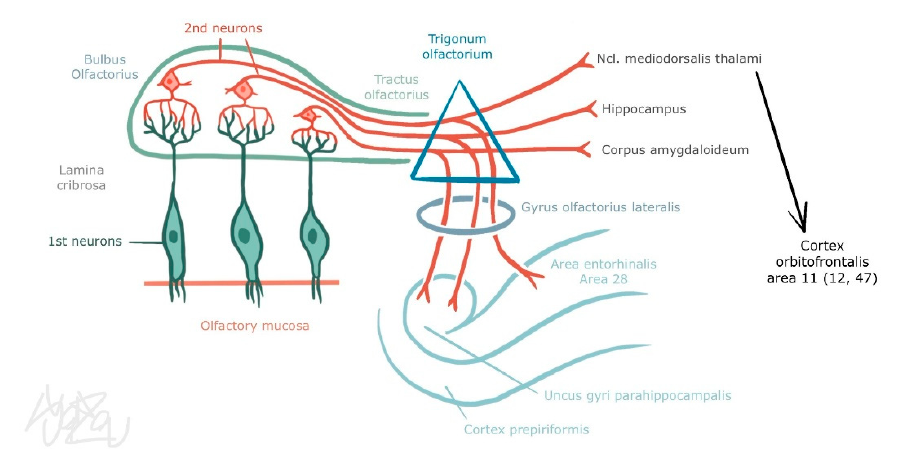
Figure 2. Olfactory pathway (from co-author’s